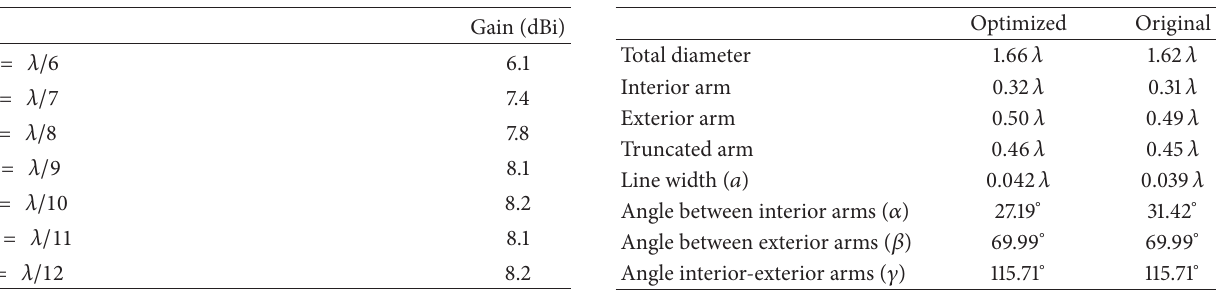
Table 5: Antenna gain substrate thickness analysis. Table 6: Optimized antenna